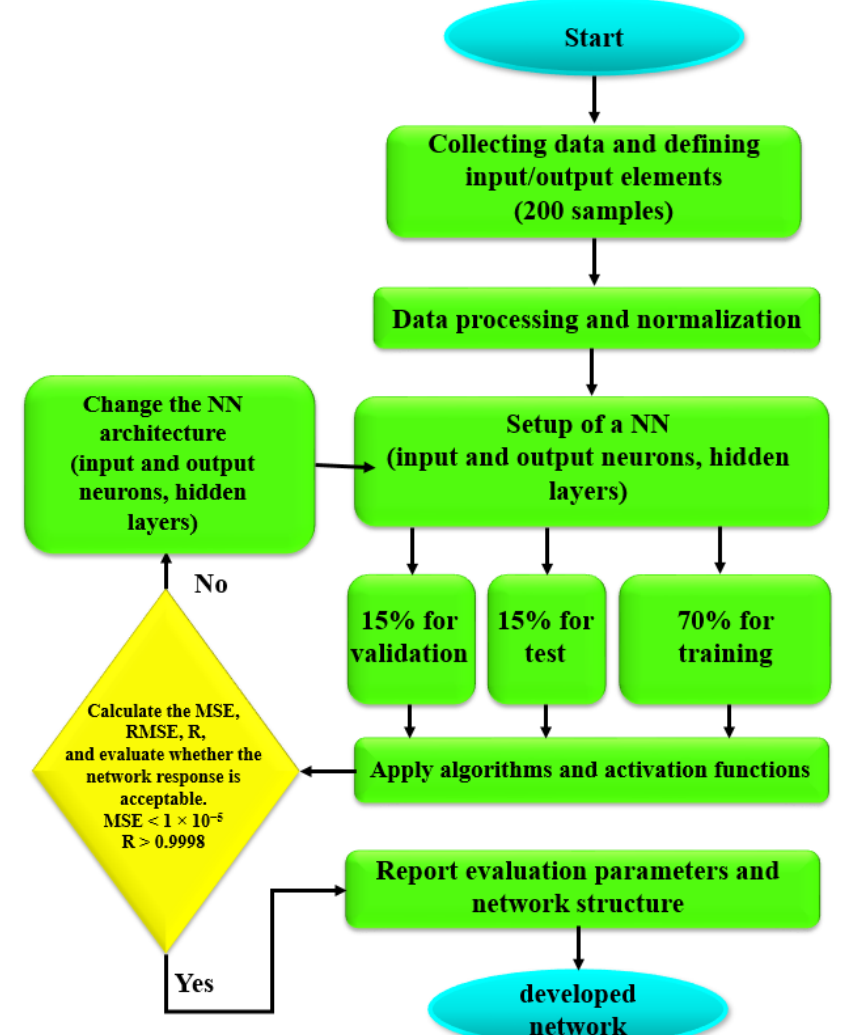
Figure 6. Flowchart of optimization for the ANN approach to finding the best network.